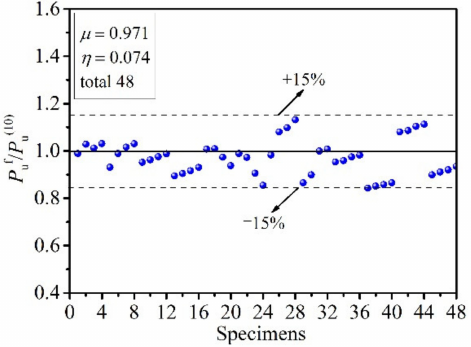
Figure 19. Comparison of shear strength between the FE results and Equation (10)